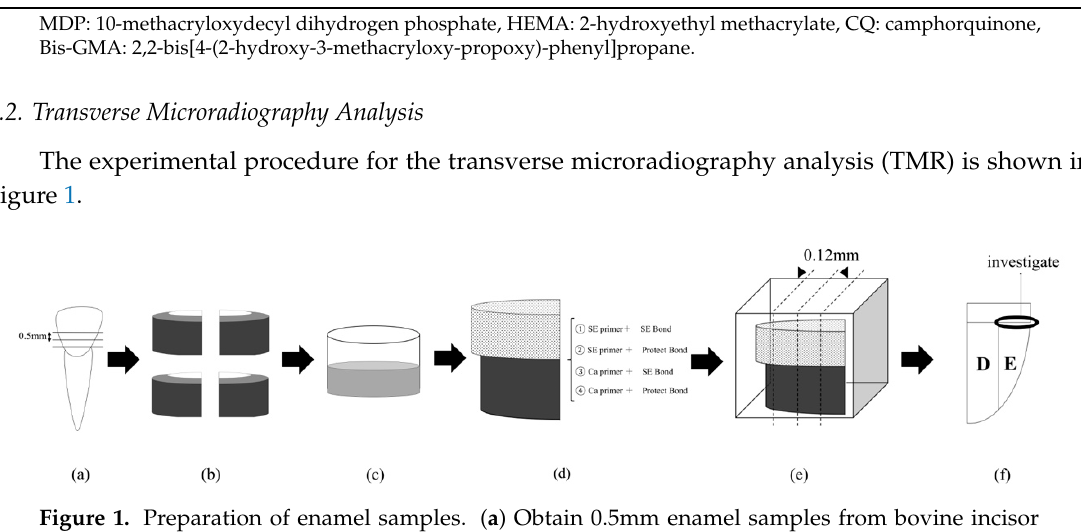
Figure 1. Preparation of enamel samples. ( a ) Obtain 0.5mm enamel samples from bovine incisor teeth. ( b ) Divide into 2 parts from buccal to lingual and make a window (2 × 2 mm) ( c ) Soak in demineralization solution for 4 days at 37 ℃ . ( d ) Apply adhesives to the four groups and build up resin composite. ( e ) Embed (epoxy resin), slice, and polish (0.12 mm) ( f ) Perform TMR analysis.